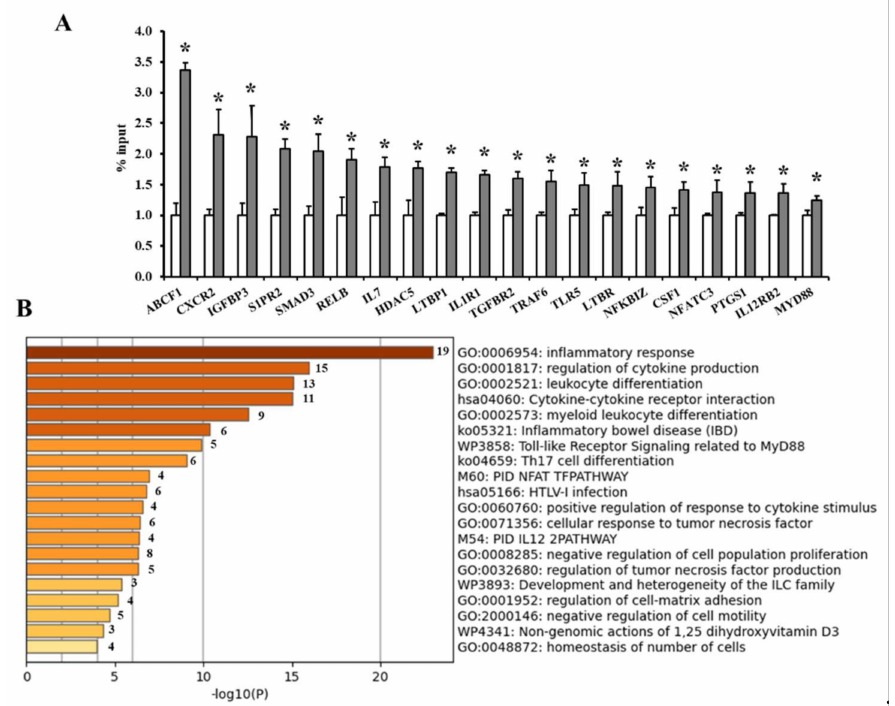
Figure 4. TET1 occupancy at adipokine promoters and gene enrichment analysis. ( A ) Average binding occupancy of TET1 across adipokine promoters in obese subjects measured via ChIP-qPCR assays and normalized to non-obese controls ( n = 60, each). Results are shown as means ± standard error (SE), and the * symbol reflects a p -value < 0.05 when comparing obese subjects with controls. ( B ) Heatmap of enriched terms across the input differently methylated gene lists, colored by p -values, via the